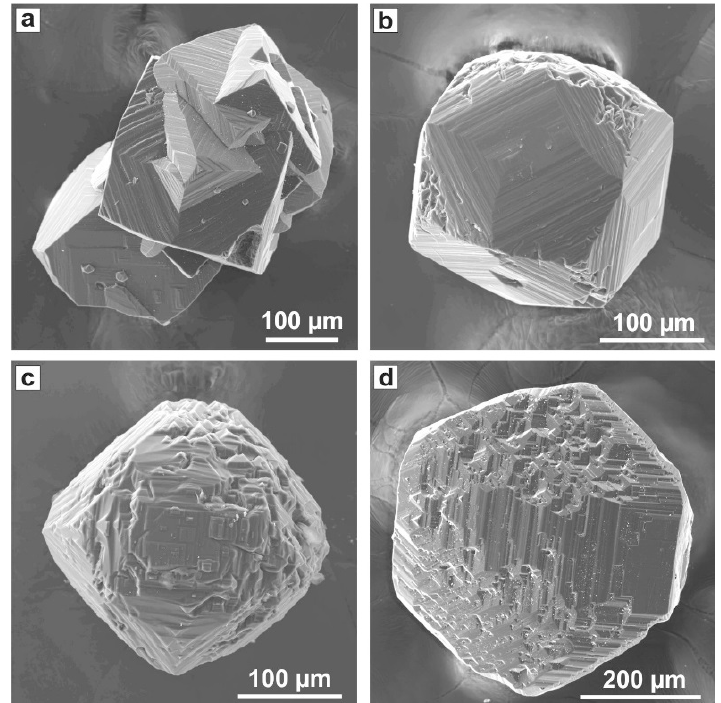
Figure 2. SEM micrographs of diamond crystals produced in the Mg-Sm 2 O 3 -C system: ( a ) intergrowth of twins and crystals of the diamond (run R-12); ( b ) a cuboctahedral diamond crystal with stepped trapezohedron faces (run R-12); ( c ) a rounded crystal bound by curve-faced surfaces (run R-12); and ( d ) regenerated surface of the seed crystal (run R-13).